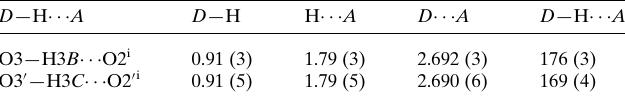
Table 2 Hydrogen-bond geometry (A˚ , (cid:2) ) for II .